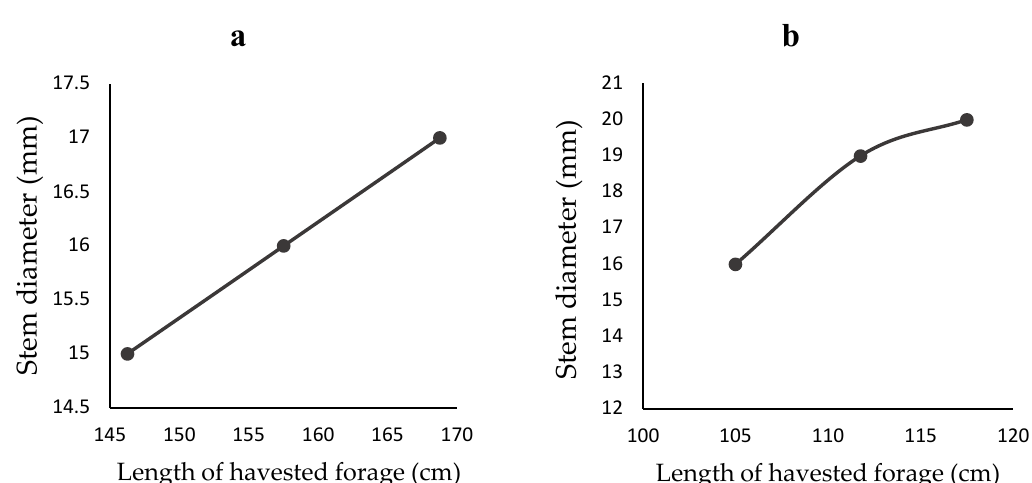
Figure 1. Change in average length of harvested forages over the cutting intervals: ( a ) CO-3 grass (n = 3) and ( b ) Maize (n = 3).